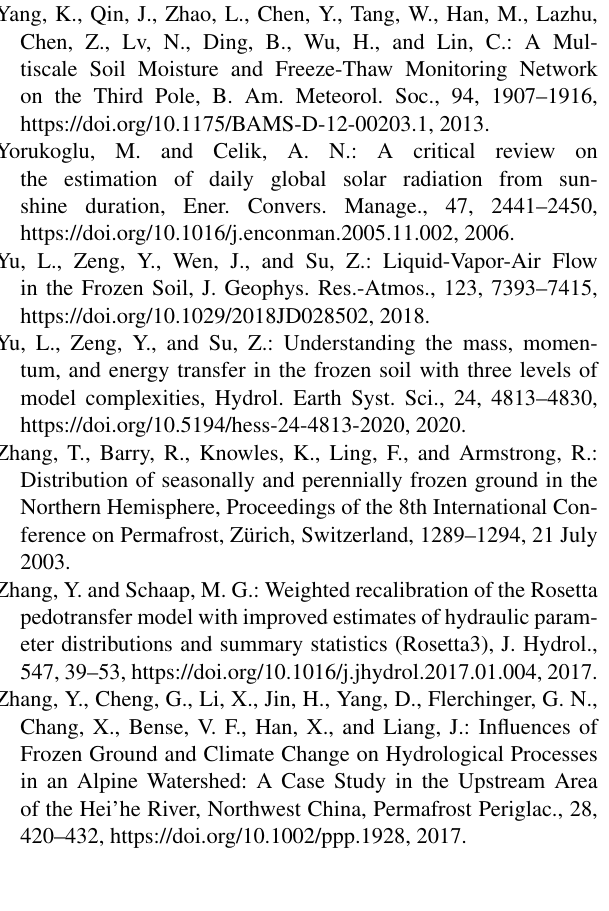
water table: a study in the Ordos Plateau, China, Hydrogeol.